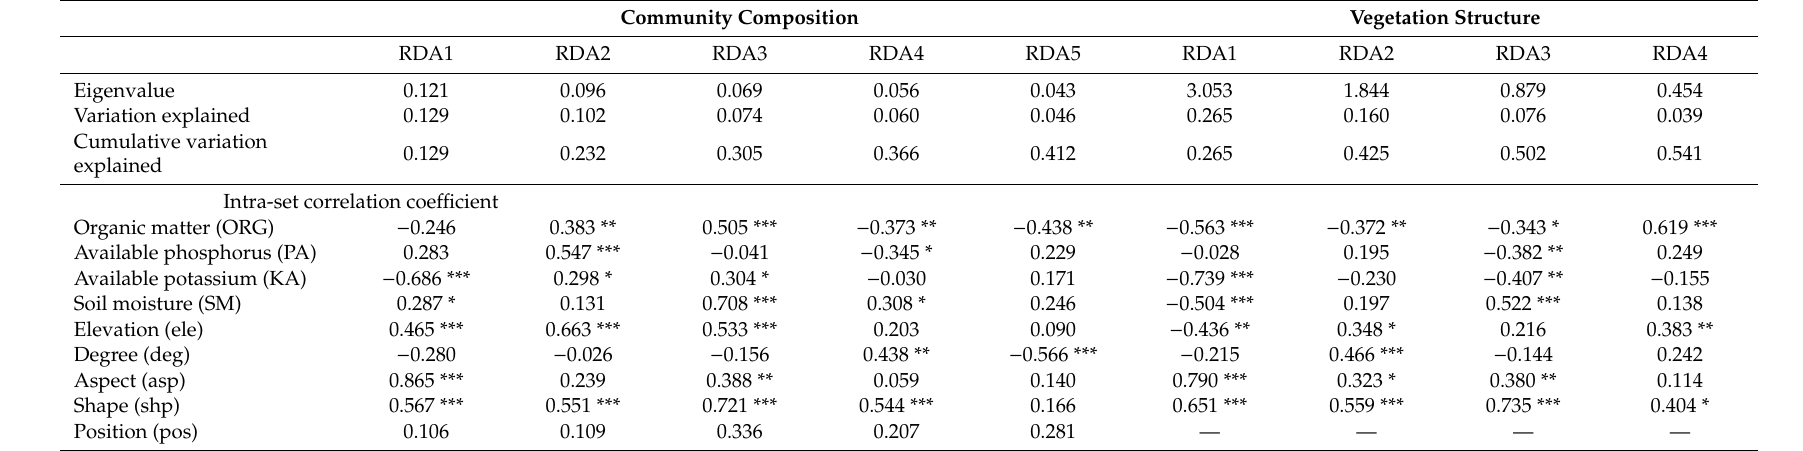
Table 4. Result of RDA of community composition and vegetation structure on environmental variables. Community Composition Vegetation Structure